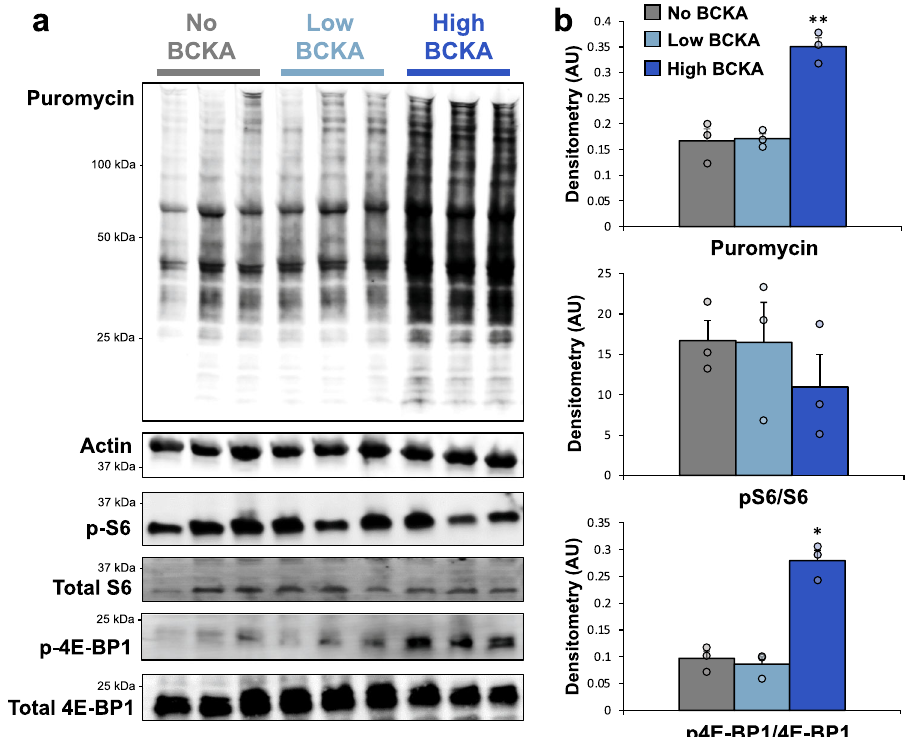
Fig. 4 High concentrations of BCKA activate protein synthesis in isolated perfused hearts in concert with increased 4E-BP1 phosphorylation. Wistar rat hearts were isolated and perfused with buffers containing no BCKA ( n = 3; gray), BCKA at concentrations found in the plasma of lean rats ( n = 3; light blue) or BCKA at concentrations found in the plasma of obese rats ( n = 3; dark blue). a Upper panel – immunoblot analysis of the incorporation of puromycin into newly synthesized proteins. Lower panel — immunoblot of total and phosphorylated ribosomal protein S6 and 4E-BP1. b Densitometric quanti fi cation of puromycin labeling (normalized to actin loading control), phosphorylated ribosomal protein S6 (normalized to total S6), and phosphorylated 4E-BP1 (normalized to total 4E-BP1). Data represent mean ± SEM. Statistical differences indicated by Tukey ’ s HSD post-hoc test following one-way ANOVA: * P < 0.05, ** P <